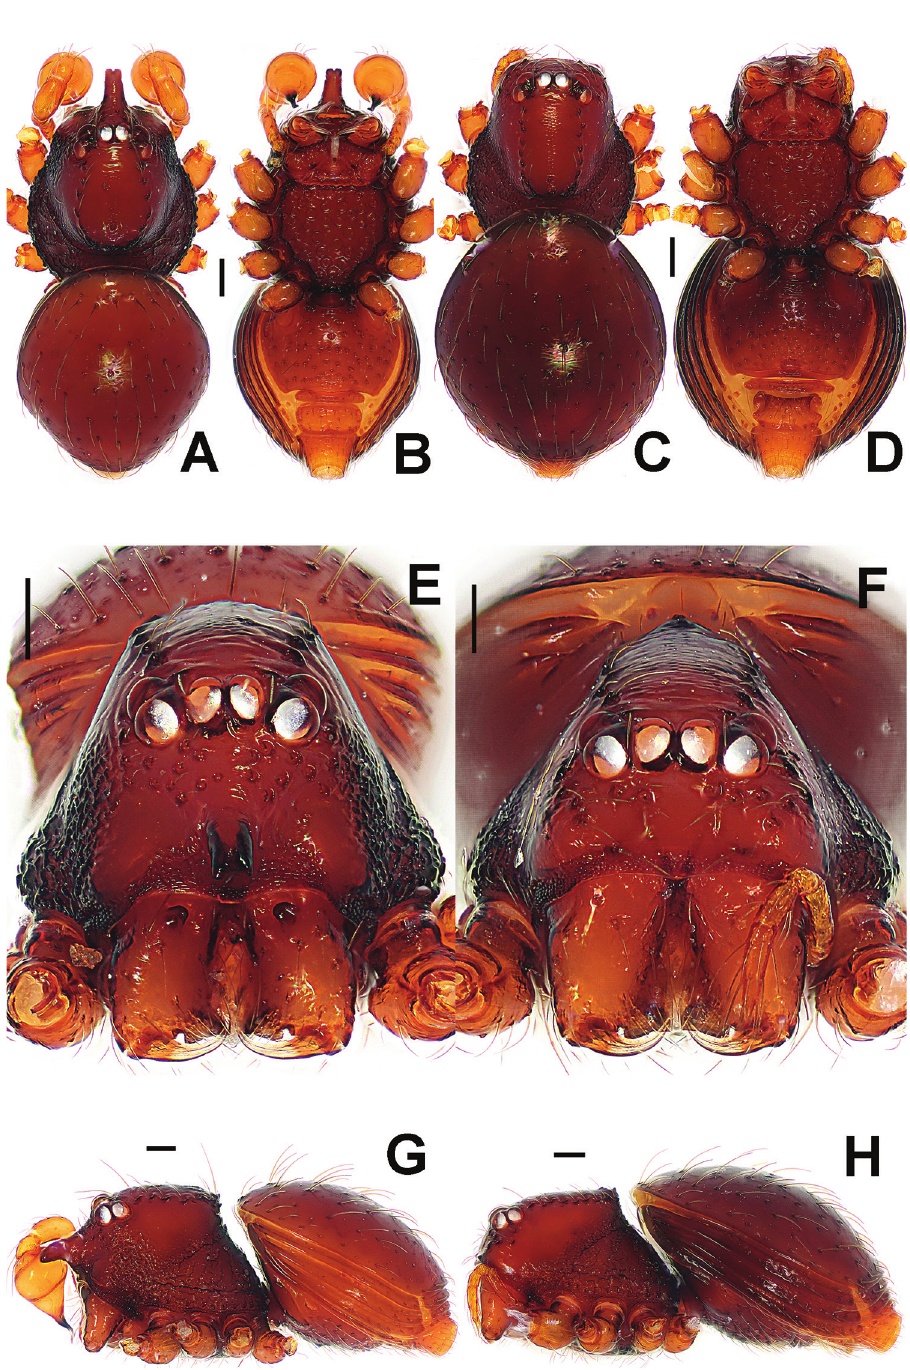
Figure 13. Brignoliella michaeli Lehtinen, 1981, male ( A–B, E, G ) and female ( C–D, F, H ) from Sin- gapore. A–D, G–H habitus E–F prosoma. A, C dorsal B, D ventral E–F anterior G–H lateral. Scale bars: 0.10